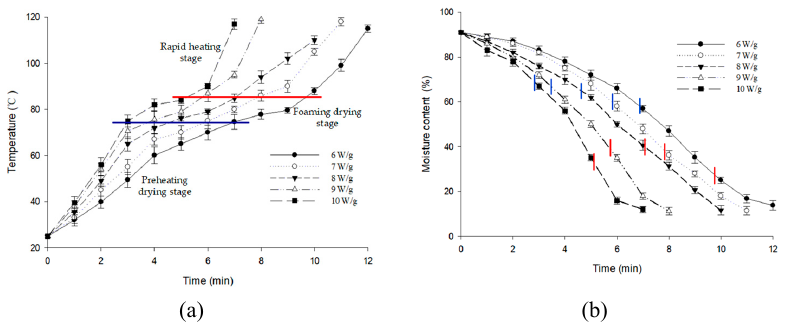
Figure 2. The characteristics of ( a ) temperature and ( b ) moisture content of the berry puree drying at varying microwave intensities. The blue line in ( a ) is the isotherm of 75 °C and the red line in ( a ) is the isotherm of 85 °C. The vertical blue and red lines in ( b ) correspond with ( a ) in the same drying time.